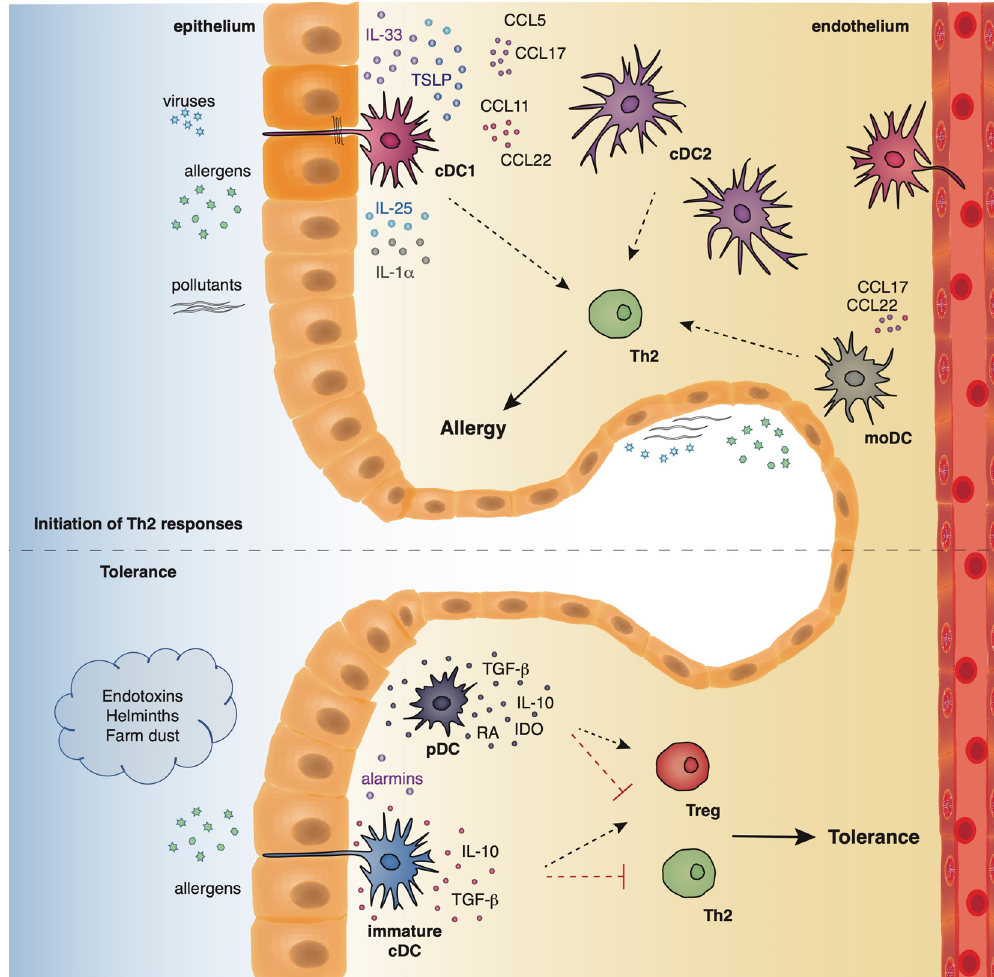
Figure 2. The location and function of different DC subsets in the airways.